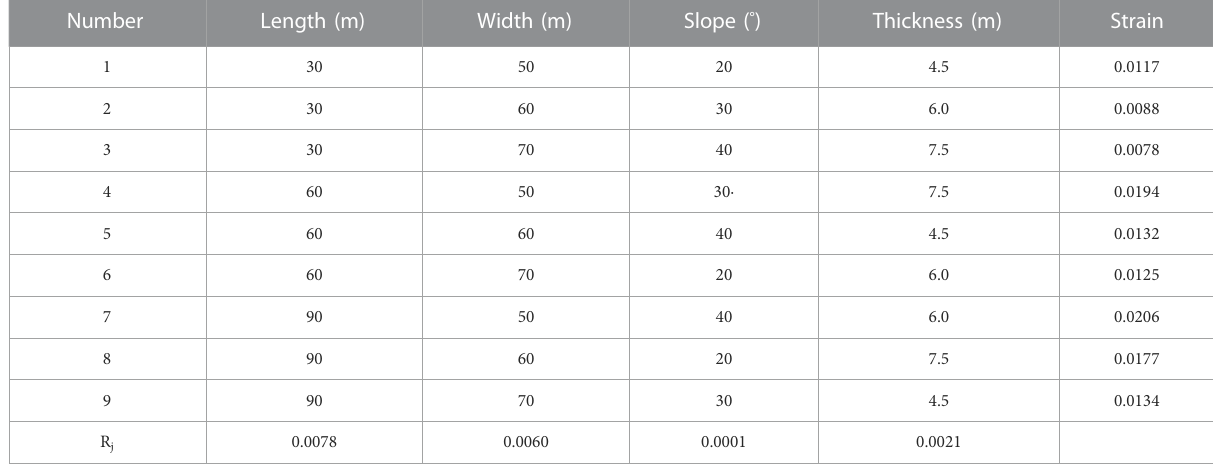
TABLE 4 Comparison of orthogonal tests of pipelines crossing landslides transversely.